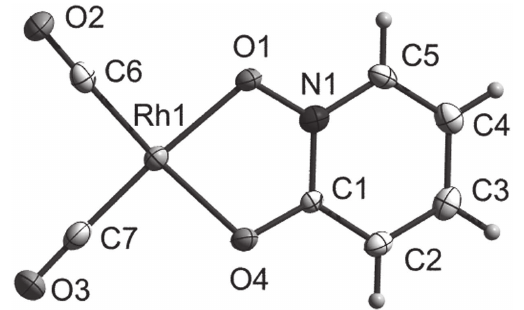
Table 1: Data collection and handling.